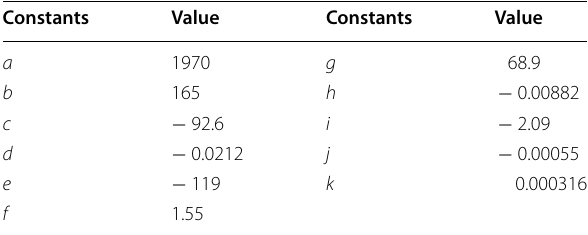
Table 6 Constants in Eq. (8)